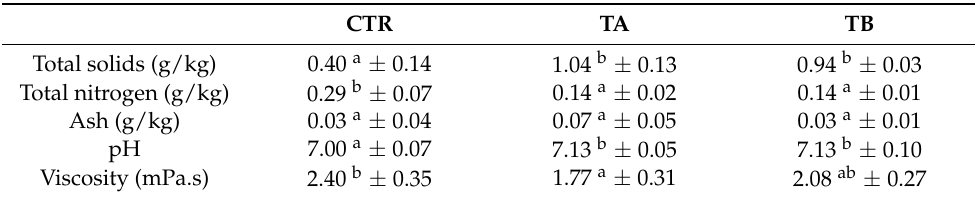
Table 2. Composition and physicochemical attributes of permeates generated from microfiltration of mTG crosslinked micellar casein concentrate feed at 5 ± 0.5 ◦